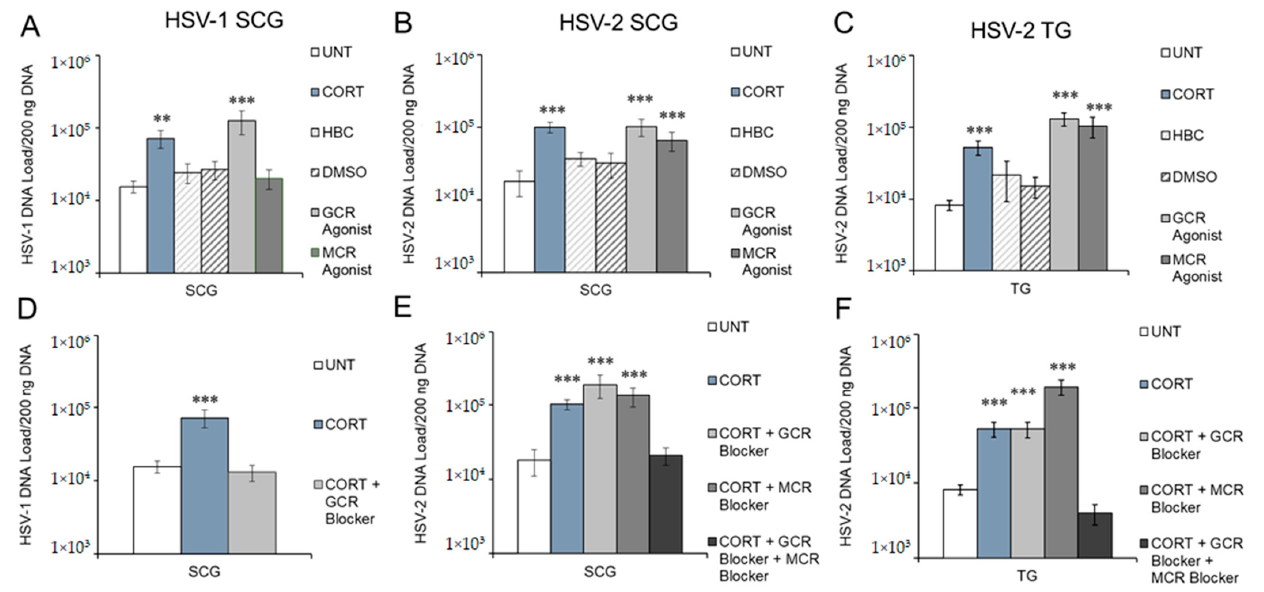
Figure 3. GR is required for CORT-induced HSV-1, but GR and MR are redundant for HSV-2 reactivation. Primary adult neuronal cultures from sensory trigeminal (TG) or sympathetic superior cervical (SCG) ganglia were infected with HSV-1 ( A , D ) or HSV-2 ( B , C , E , F ) in the presence of acyclovir for 7 days, followed by treatment with corticosterone (CORT), receptor agonists, or receptor antagonists. ( A ) HSV-1 or ( B ) HSV-2 latently infected sympathetic SCG neuronal cultures were treated with CORT, CORT vehicle HBC, agonist vehicle DMSO, GR agonist (dexamethasone), or MR agonist (aldosterone). ( C ) HSV-2 latently infected sensory TG neuronal cultures were treated with CORT, CORT vehicle HBC, agonist vehicle DMSO, GR agonist (dexamethasone), or MR agonist (aldosterone). ( D ) HSV-1 latently infected SCG neuronal cultures were treated with CORT, either alone or with GR antagonist (mifepristone). HSV-2 latently infected SCG ( E ) or TG ( F ) neuronal cultures were treated with CORT, either alone, with GR antagonist (mifepristone), with MR antagonist (eplerenone), or with both the GR and MR antagonists. Viral DNA was quantified in A–F by DNA collected 24 h posttreatment measured by qPCR. Data are means ± SEM, n > 6; results were compared to untreated cultures by ANOVA and post hoc Tukey’s HSD; ** p < 0.01; *** p < 0.001.